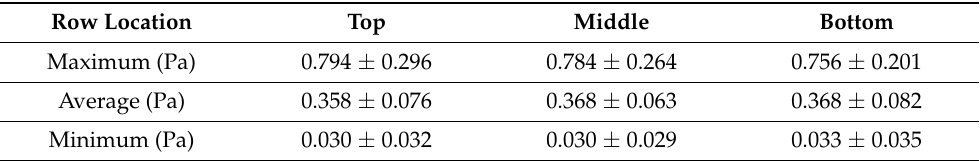
Table 1. Row averages of the average, maximum, and minimum total shear stresses for revolutions